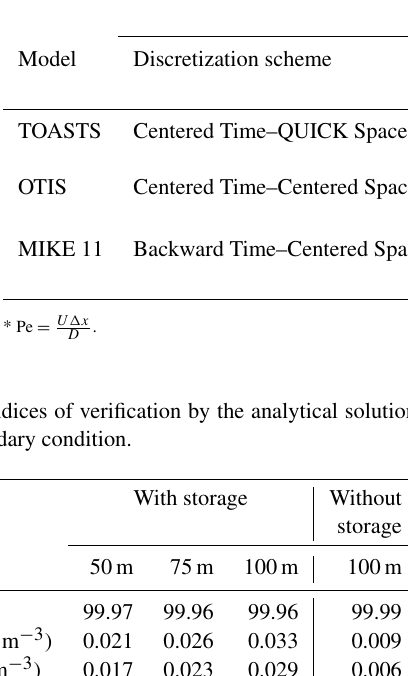
Table 2. Comparison of numerical methods used in the three models.